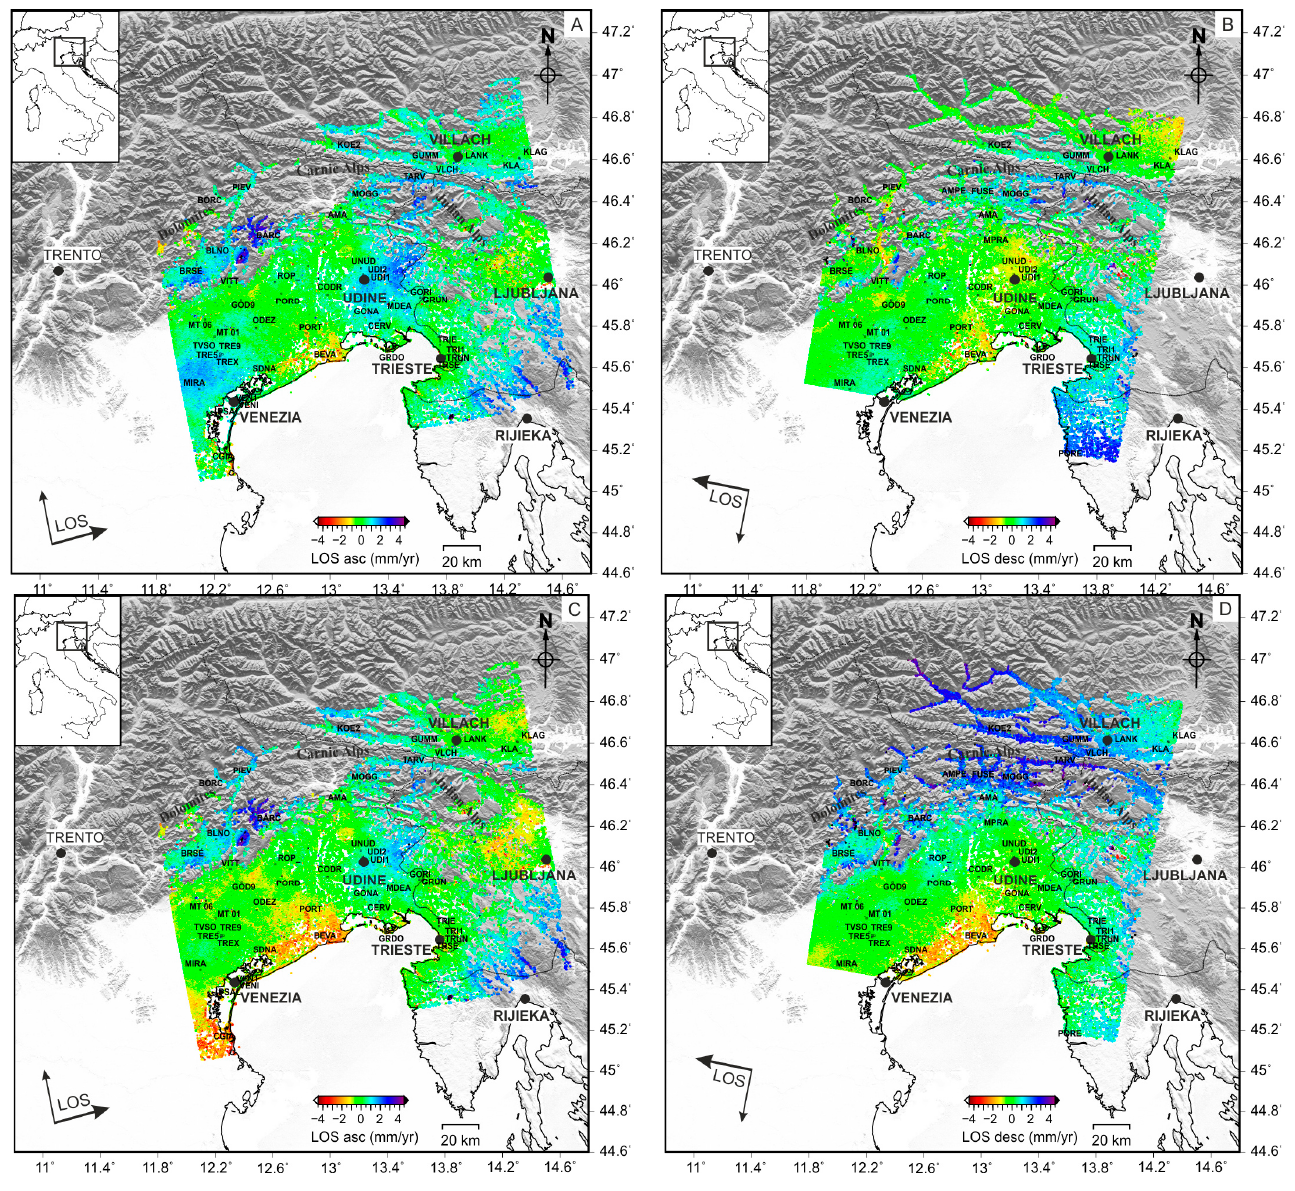
Figure 4. LOS Velocity maps. The LOS mean ground displacement maps before ( A , B ) and after the calibration ( C , D ) for the ascending ( A – C ) and descending ( B – D ) tracks. The black points indicate the location of the GNSS stations used for the calibration. Positive and negative values indicate movements towards and away from the satellite, respectively.